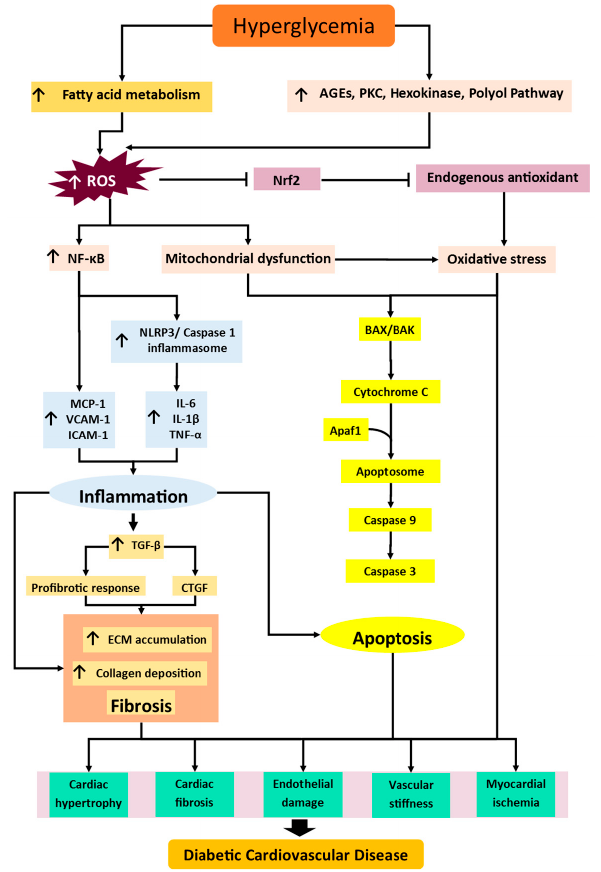
Figure 1. The illustrated mechanisms propose the pathogenesis of diabetic CVD. Hyperglycemia is the main culprit that induces and enhances the activation of fatty acid metabolism and nonoxidative glucose pathways, AGEs, polyol, hexosamine, and PKC pathways, which cause high generation of ROS. ROS causes downregulation of Nrf2, which reduces the activity and level of endogenous antioxidants, which ultimately causes oxidative stress. ROS also triggers the activation of NF- κ B and raises the inflammasome, NLRP3, and inflammatory cytokines (TNF- α , IL-6, IL-1 β , MCP-1, ICAM-1, VCAM-1), which leads to inflammation. The inflammatory response upregulates TGF- β and triggers the profibrotic response, as well as CTGF, which further causes ECM accumulation, collagen deposition, and, in the end, fibrosis. ROS causes mitochondrial dysfunction and further enhances oxidative stress. Mitochondrial dysfunction and oxidative stress triggers the cascade of apoptosis by activating apoptosomes and caspases. These mechanisms ultimately cause cardiac hypertrophy, cardiac fibrosis, endothelial dysfunction, vascular stiffness, myocardial ischemia, and ultimately, diabetic CVD. Abbreviations: AGE, advanced glycation end product; PKC, protein kinase C; ROS, reactive oxygen species; Nrf2, nuclear factor erythroid 2-related factor 2; NF- κ B, nuclear factor kappa- light-chain-enhancer of activated B cells; NLRP3, NLR family pyrin domain containing 3; TNF- α , tumor necrosis factor alpha; IL, Interleukin; MCP-1, monocyte chemoattractant protein-1; ICAM-1, intercellular adhesion molecule 1; VCAM-1, vascular cell adhesion protein 1; CTGF, connective tissue growth factor; ECM, extracellular matrix; TGF- β , transforming growth factor beta ; Apaf-1, apoptotic protease activating factor 1. Arrow represent the subsequent event/product in the